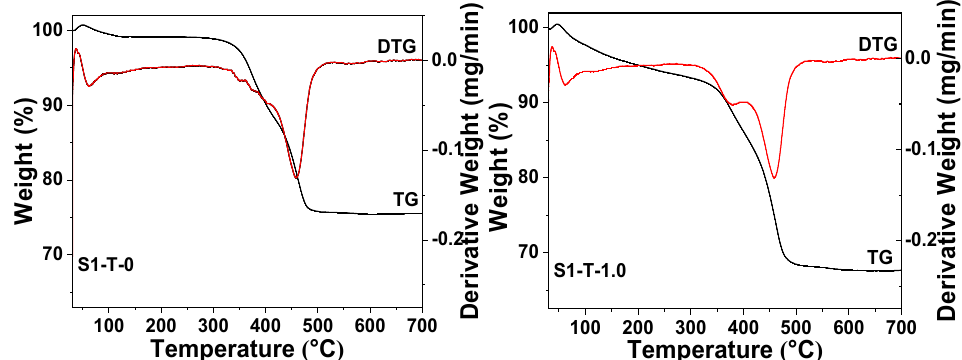
Figure 10. Thermogravimetric-Derivative thermogravimetry (TG-DTG) curves of samples under different TEA molar amounts.